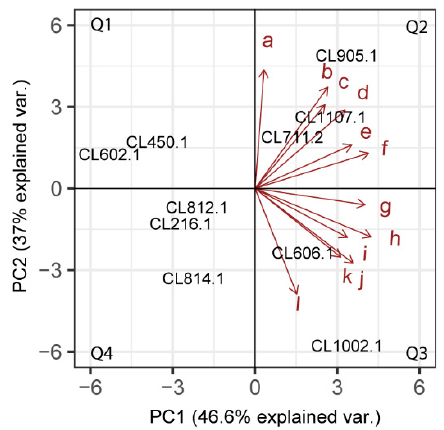
Figure 4. Principal Component Analysis of VC production across S. eubayanus strains. Distribution of the selected strains based on the leading VCs produced. a: Phenethyl Alcohol, b: Ethyl hexadecanoate, c: Octanoic acid, d: Ethyl tetradecanoate, e: Phenethyl acetate, f: Ethyl dodecanoate, g: n-Decanoic acid, h: Isoamyl decanoate, i: 4-vinyl guaiacol, j: Ethyl decanoate, k: Phenethyl decanoate, l: Ethyl